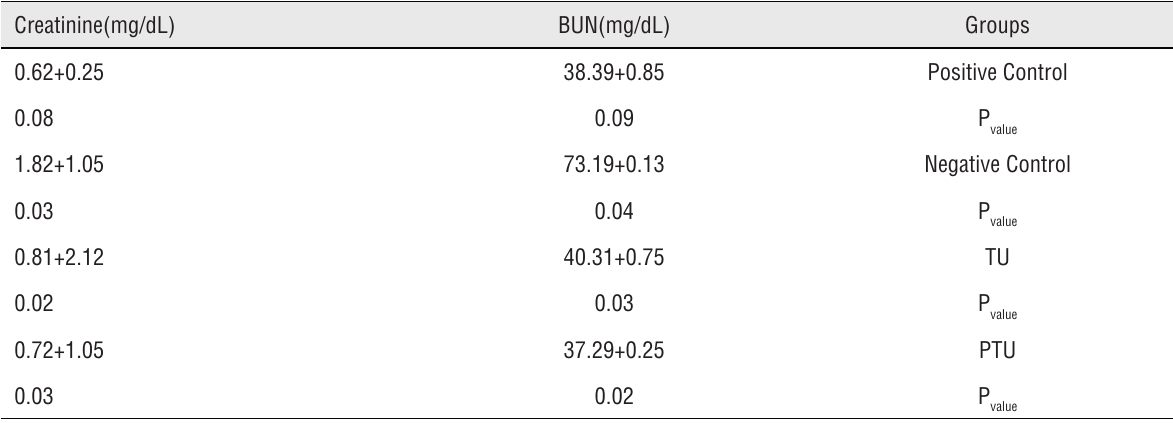
Table 3 - Serum BUN, Creatinine levels after 30days.